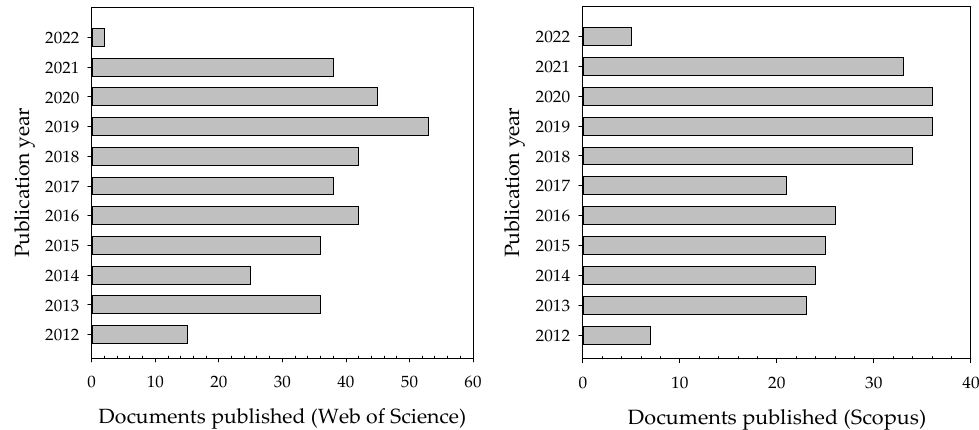
Figure 1. Number of documents published annually according to Web of science and Scopus.